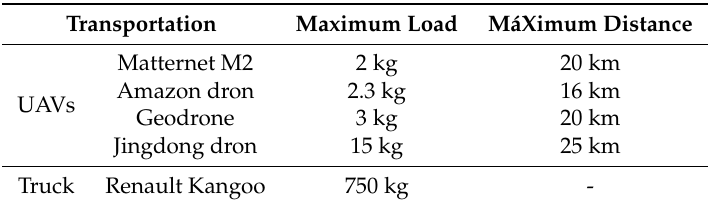
Table 1. Transport modes. Source: based on